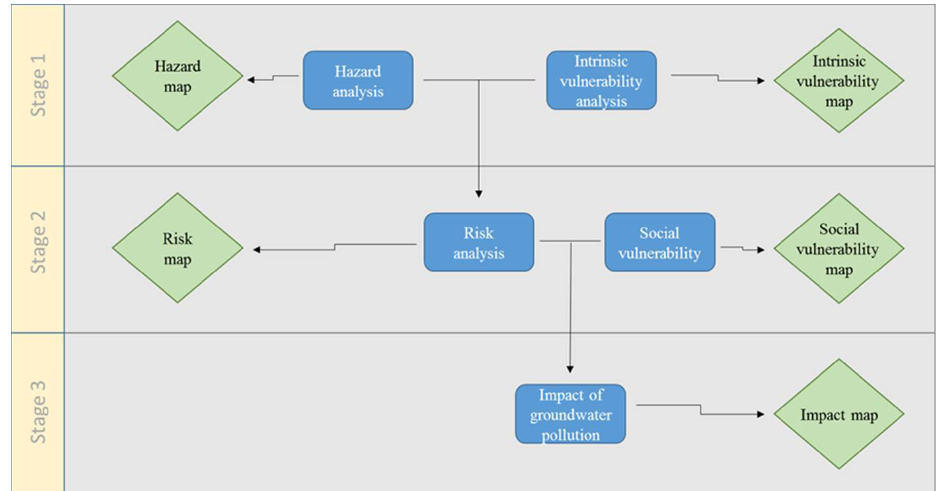
Figure 3. Flow chart of the procedure.